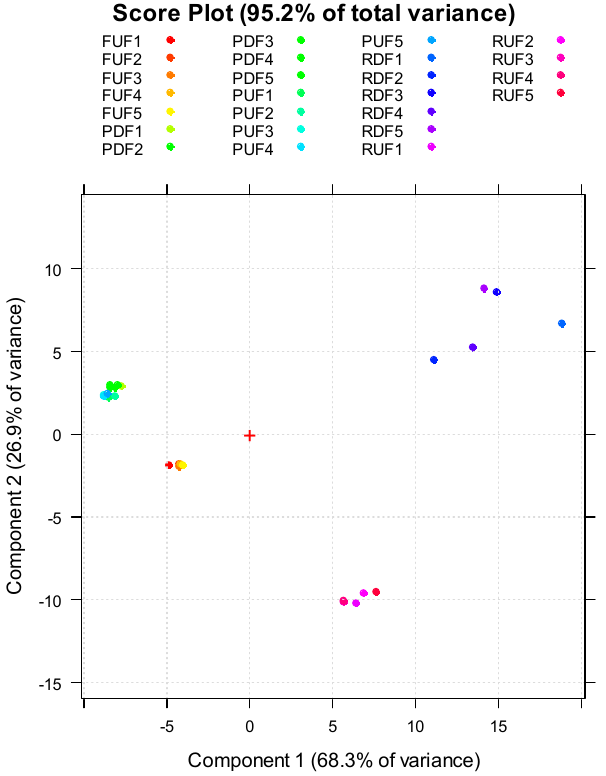
Component 1 (68.3% of variance) Figure 7. Principal component analysis score plot of the studied UF/DF samples using NMR data. The two principal components in this score plot explain 95.2% of the total variance. We can observe that feed samples differ from the retentate samples (in turn, the retentates from ultrafiltration and diafiltration are separated into two different regions of the diagram). In contrast, the permeate samples separate from the feed and retentate samples but fall into the same region, indicating their similar composition in metabolites identified through